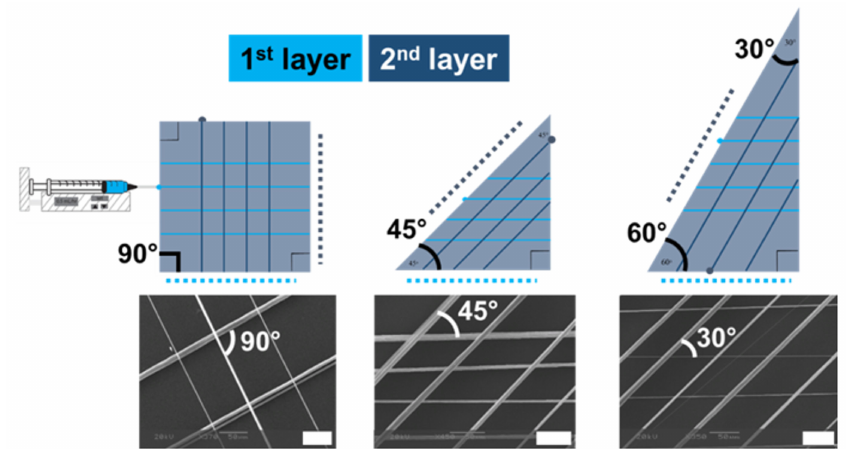
Figure 2. Representative hierarchical structures of multiple fiber layers with 50 micron scale bar. The angle between the fibers was dictated by collector geometry. Orthogonal fibers were achieved with rectangular collectors. The first layer of fibers was deposited, the collector was rotated 90 ◦ , finally, a second, orthogonal layer of fibers was deposited. Triangular collectors were used to layer fibers at 30 ◦ or 45 ◦ . The dotted lines represent the side of the collector that is placed in the holder for depositing the first layer (light blue) and second layer (dark blue).